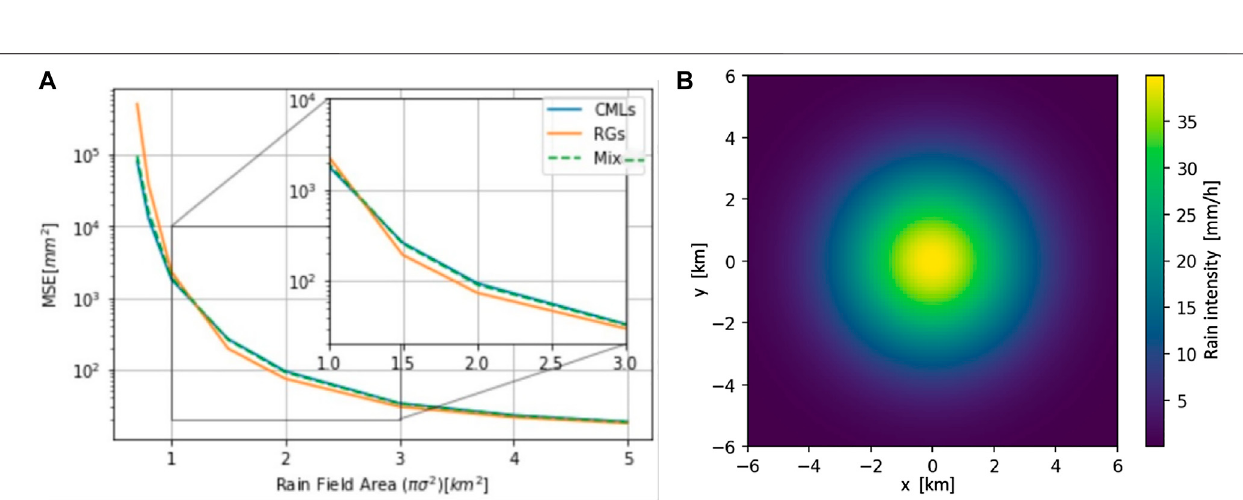
Frontiers in Signal Processing |